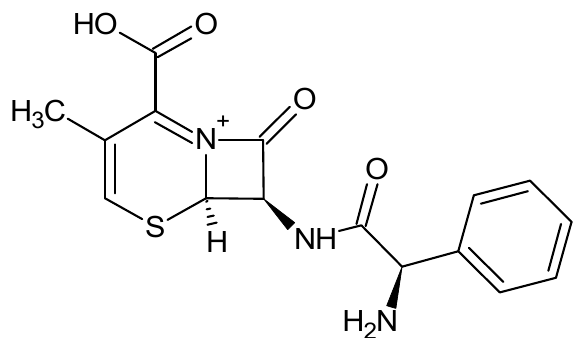
Figure 1. Chemical structure of cephalexin. (CAS 15686-71-2; molecular formula: C 16 H 17 N 3 O 4 S; MW = 347.40 g/mol).